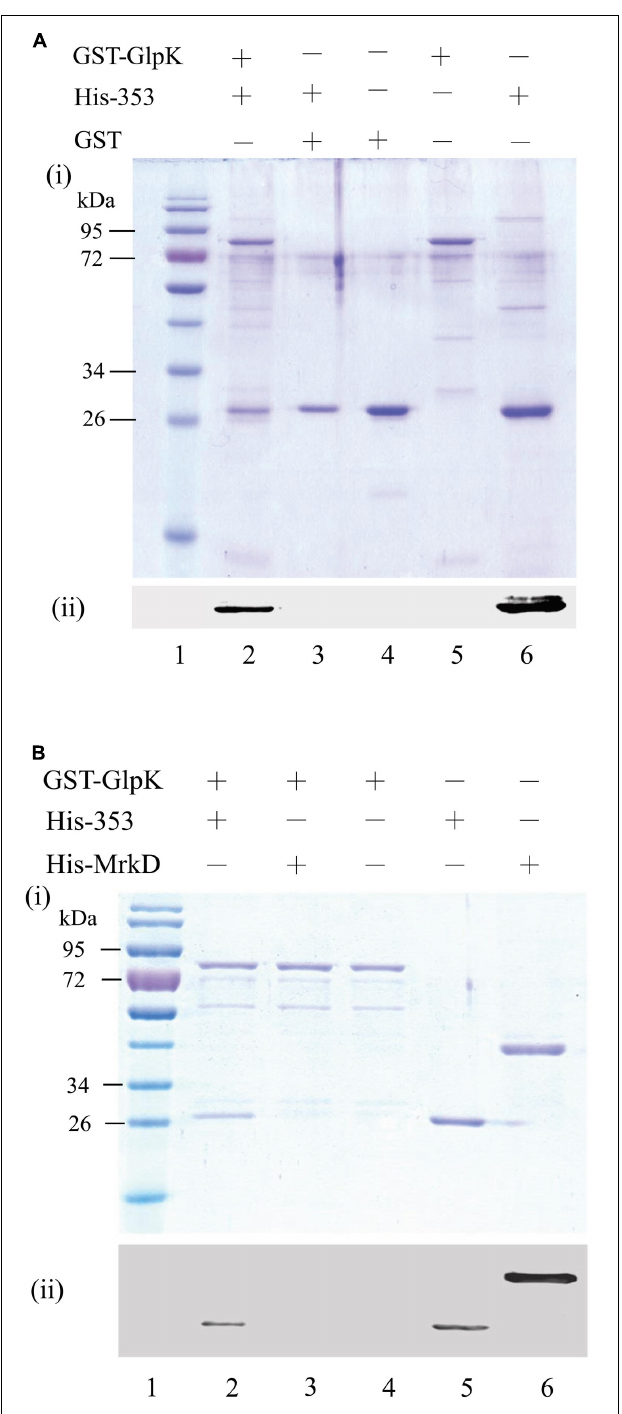
proteins compared with that in the vector control ( Figure 6